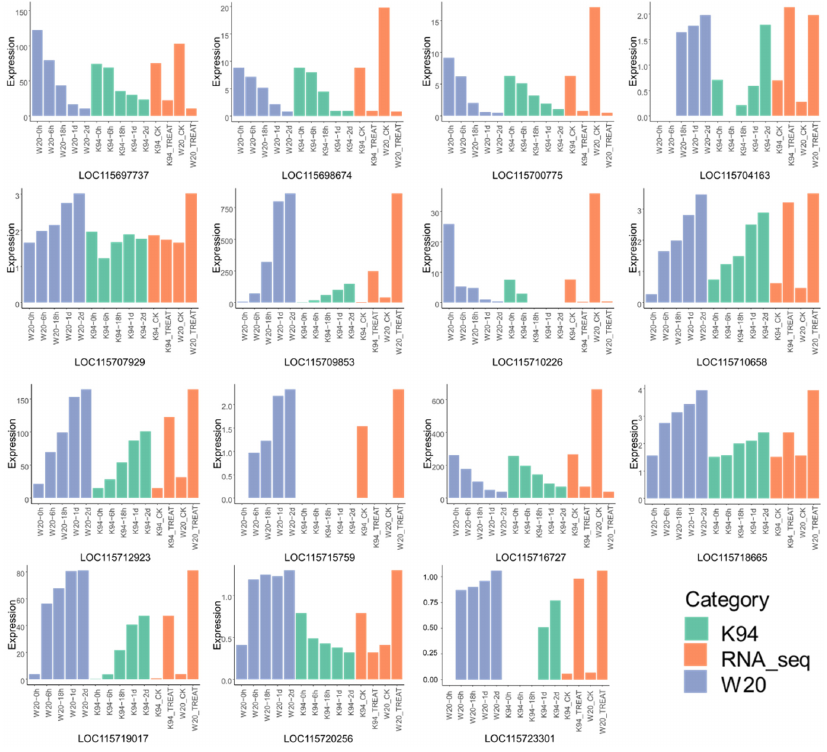
Figure 11. Expression profiles of DEGs which were selected based on qRT ‐ PCR and the TPM. Green represents the ex ‐ pression of the K94 variety at different stages after treatment based on the qRT ‐ PCR; orange represents the TPM expression of treatment and control samples based on the RNA ‐ seq; blue ‐ violet represents the expression of the W20 variety at dif ‐ ferent stages after treatment based on qRT ‐ PCR.